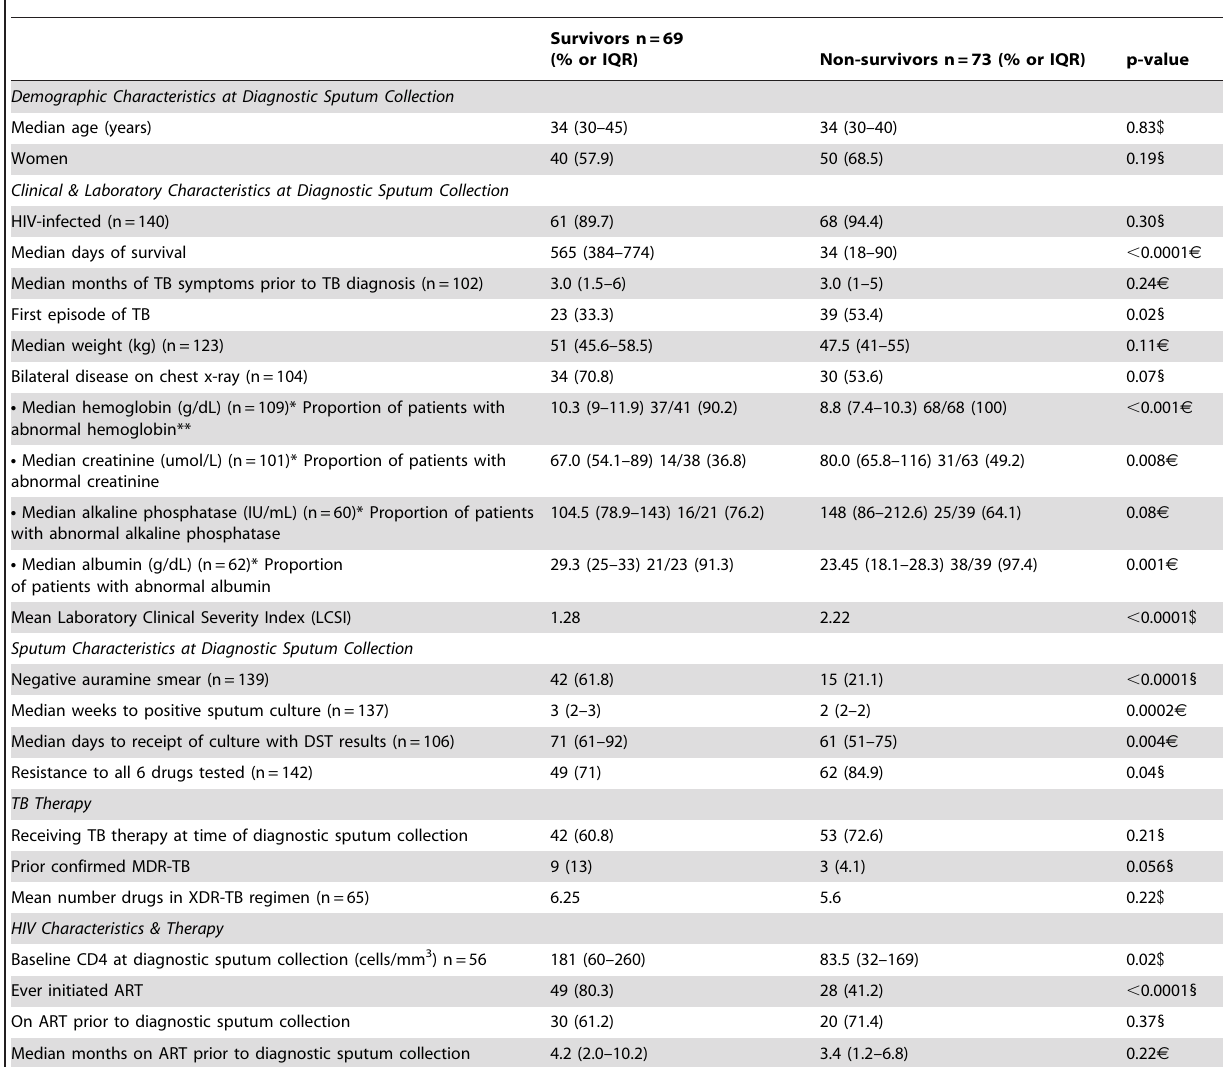
Table 1. Demographic, Clinical, Sputum, and TB& HIV Treatment Characteristics Among Survivors & Non-survivors of XDR-TB